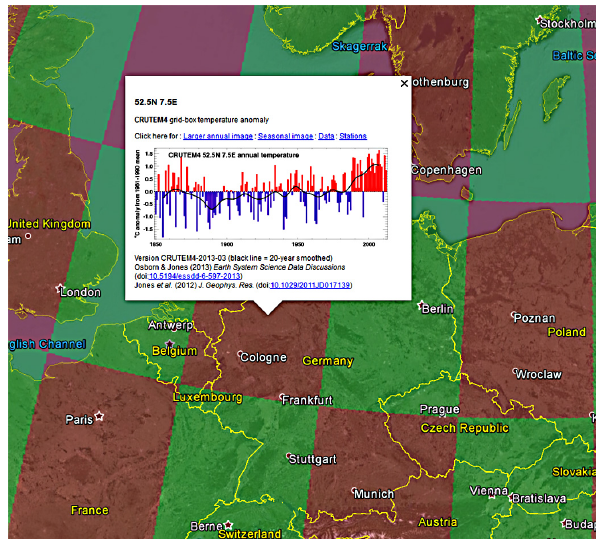
Figure 2. Image from Google Earth showing the grid boxes that contain some gridded temperature anomaly data in CRUTEM4, highlighted by translucent green and red boxes. Land areas that are not marked by a green or red box do not contain any gridded tem- perature anomaly data in the CRUTEM4 data set.